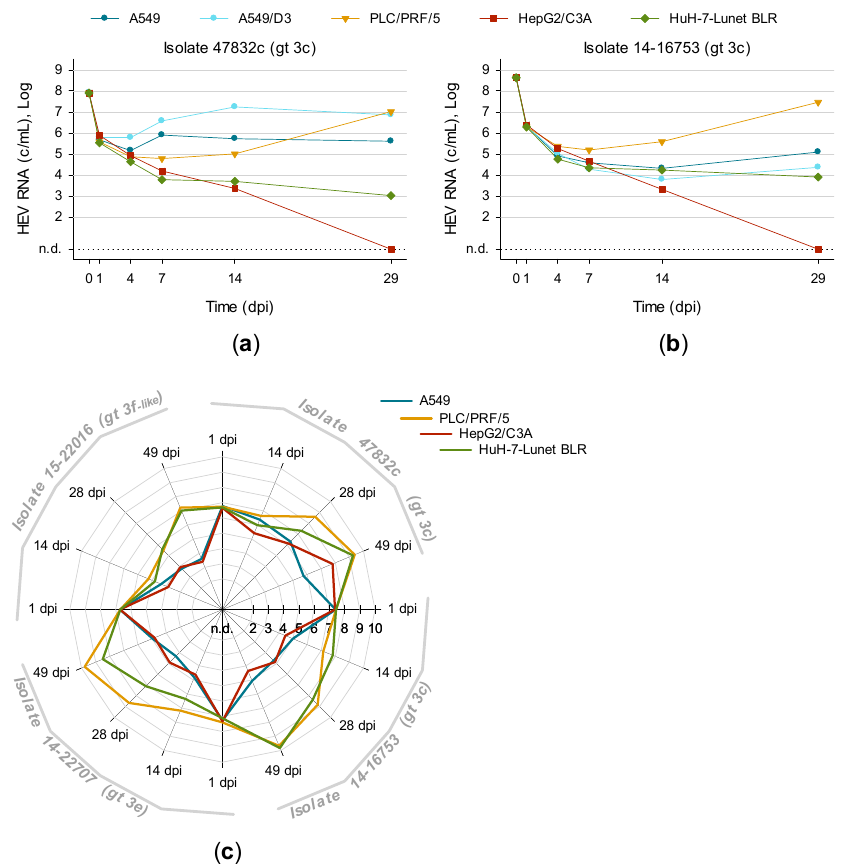
Figure 4. Effect of cell lines on de novo infection with different HEV strains. A549, its subclone A549/D3, PLC/PRF/5, HepG2/C3A and HuH-7-Lunet BLR were inoculated with either ( a ) isolate 47832c or ( b ) isolate 14-16753. Supernatants were tested for HEV RNA at 1, 4, 7, 14 and 29 days post inoculation (dpi). Results are shown as the mean of technical triplicates. ( c ) A549, PLC/PRF/5, HepG2/C3A and HuH-7-Lunet BLR were inoculated with isolate 47832c, 14-16753 or 14-22707 as well as with serum 15-22016 positive for HEV gt 3f-like. After 1, 14, 28 and 49 dpi supernatants were tested for HEV RNA. N.d., not detected.